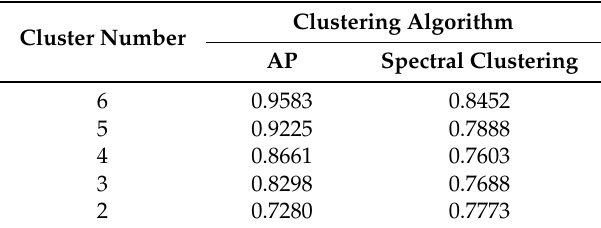
Figure 6. Clustered similarity matrices for the charge curves; ( a ) The AP algorithm; ( b ) The spectral clustering algorithm. Table 1. Silhouette indexes for charge curves.